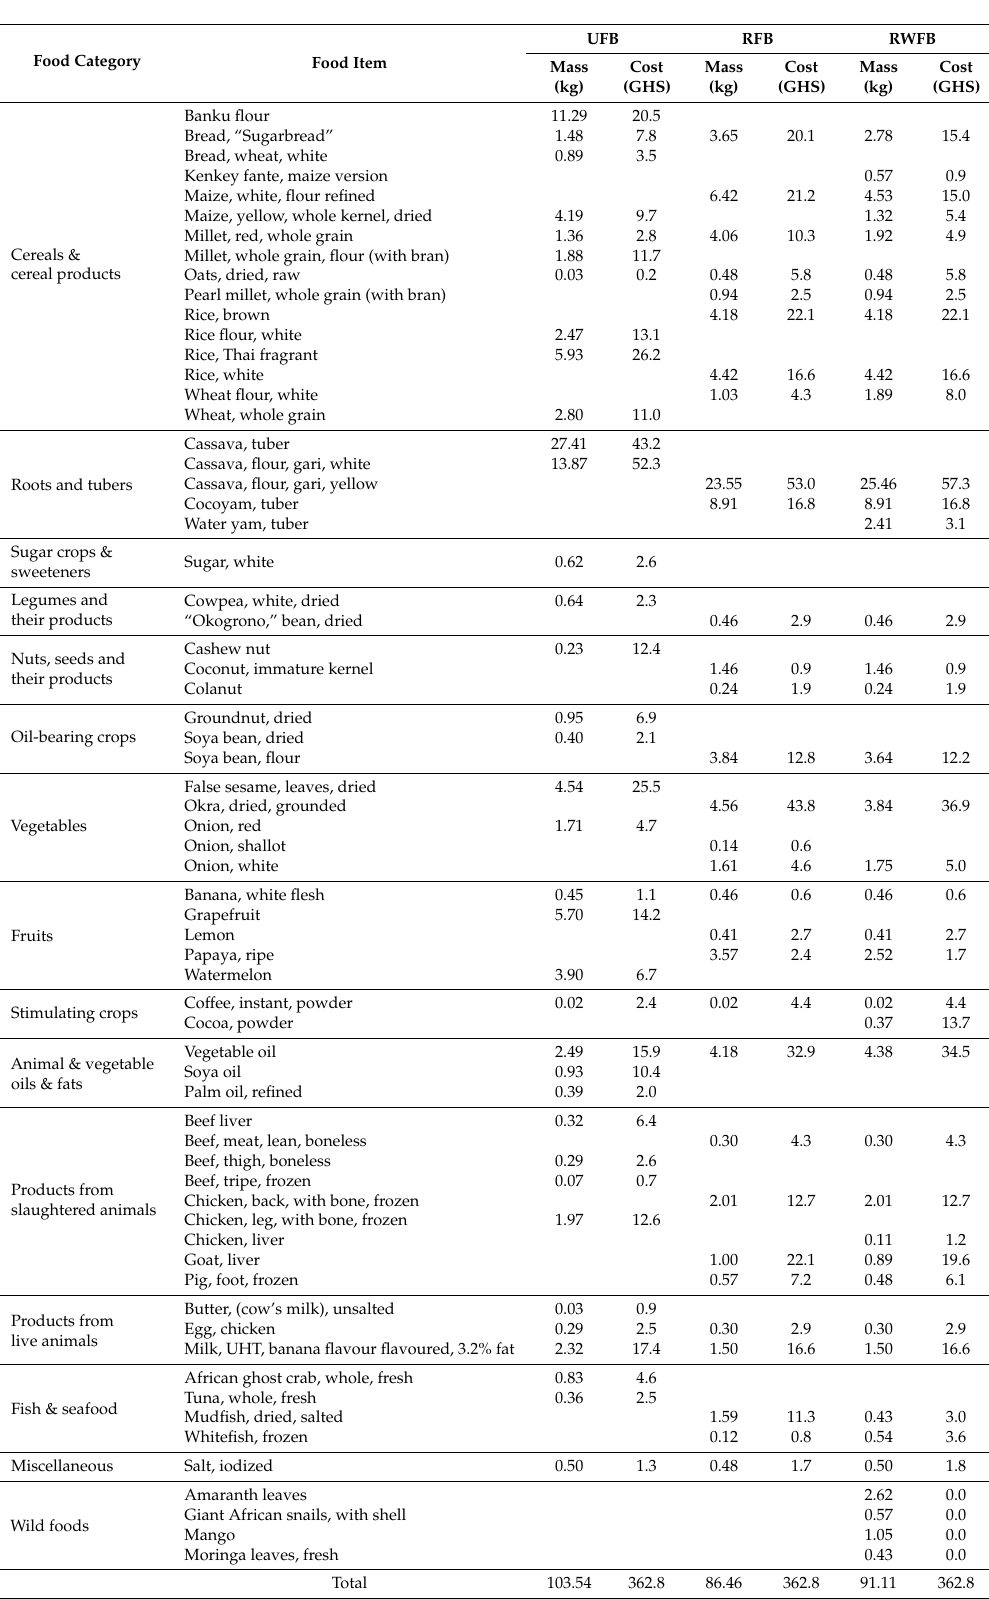
Table 5. Composition of a monthly urban food basket (UFB, 36 foods), rural food basket without wild foods (RFB, 31 foods) and rural food basket including wild foods (RWFB, 39 foods) costing GHS 11.9 (USD 3.1) per day which has been optimized for similarity towards the most recent food supply patterns from FAOs food balance sheets